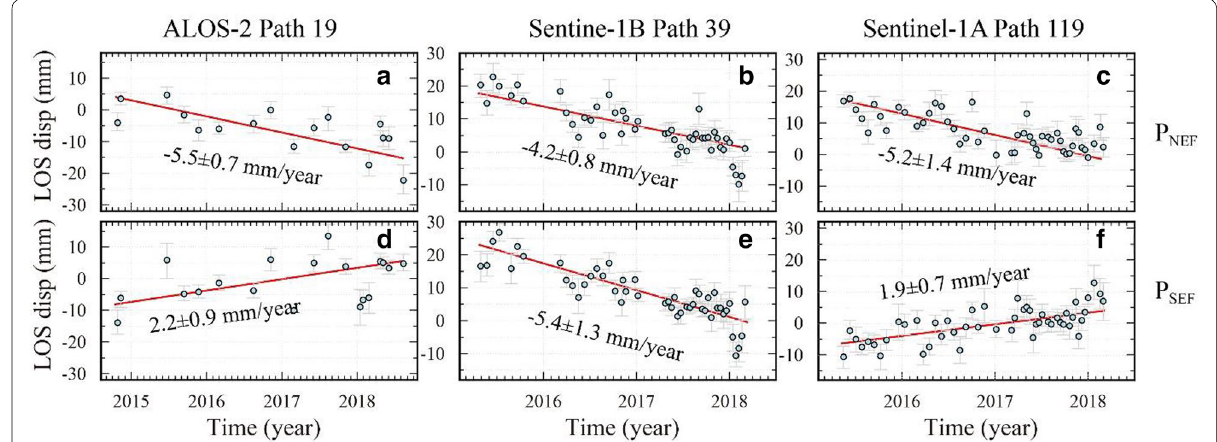
Fig. 9 Time series of LOS changes at the two selected points P NEF and P SEF (Fig. 7). a ‒ c Time series at P NEF from the ALOS-2, ascending Sentinel-1, and descending Sentinel-1 images. d ‒ f Similar to a – c but for the point P SEF . Error bars are standard deviations estimated over the points located within a window with size of 3 3 pixels ×